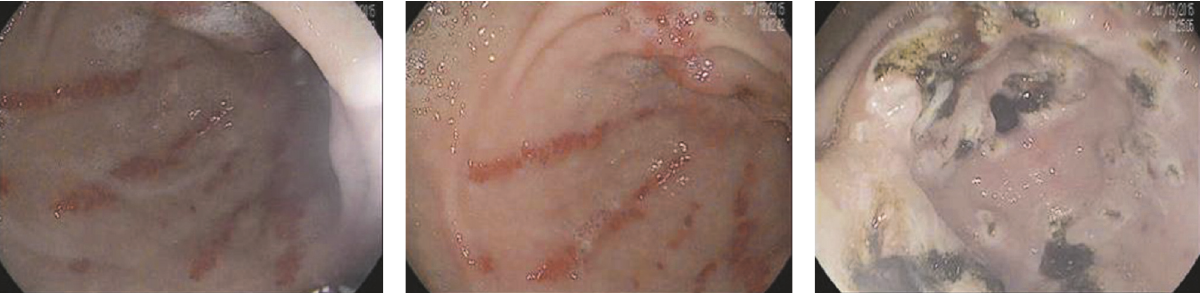
Figure 2: Gastric antral vascular ectasia seen in our patient on endoscopic examination 864 days following